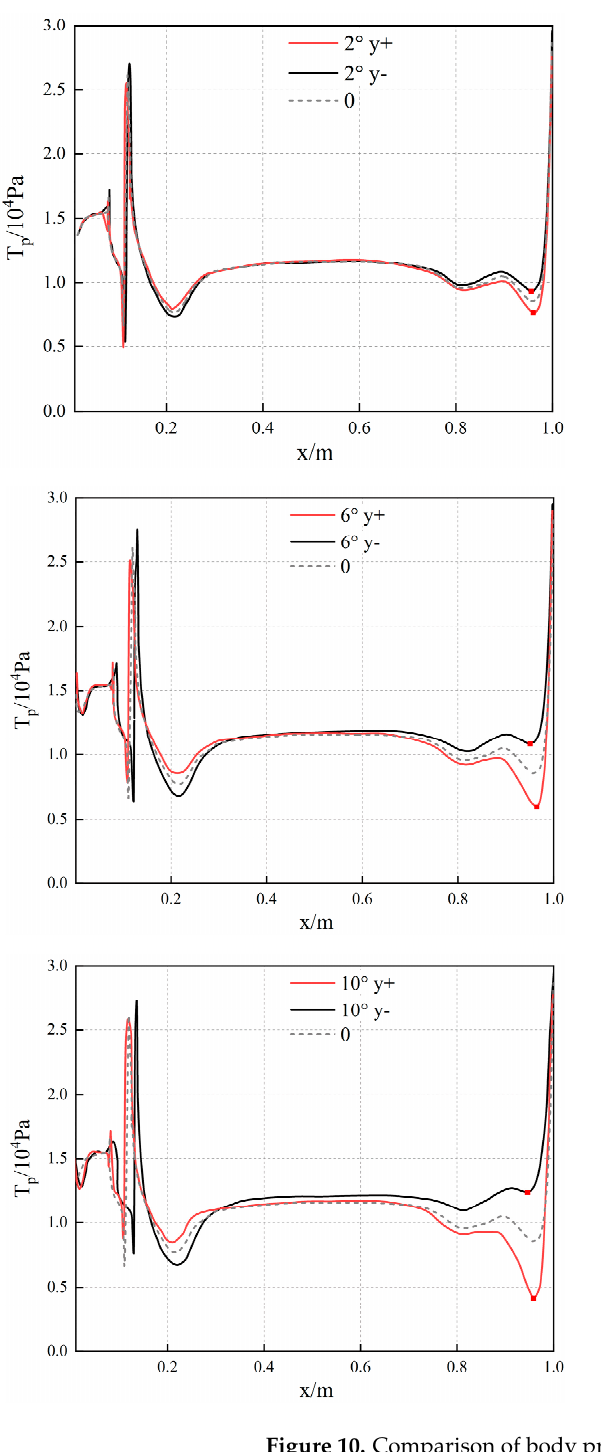
Figure 10. Comparison of body pressure at different drift angles.